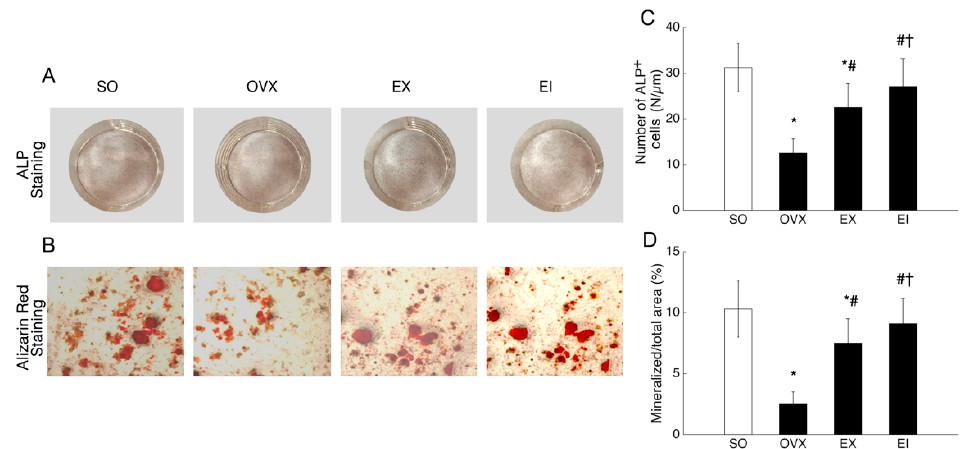
Figure 1. ALP + cell number and mineralized nodule area. SO: Sham-operated; OVX: ovariectomized; EX: exercise; EI: exercise and Icariin. 1. Comparison of the groups of OVX, EX, and EI with sham